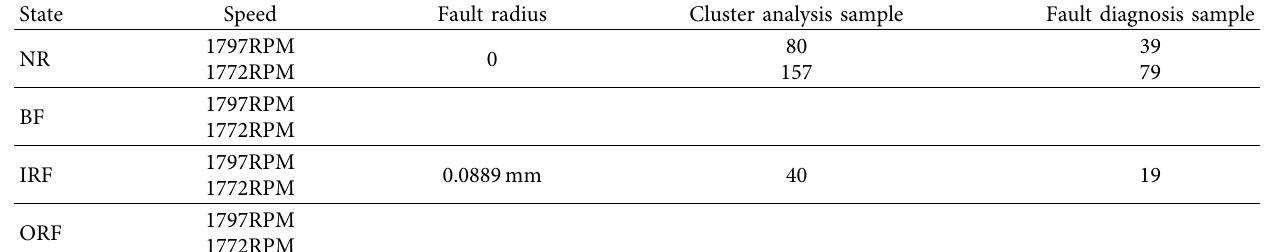
Table 3: Fault samples.